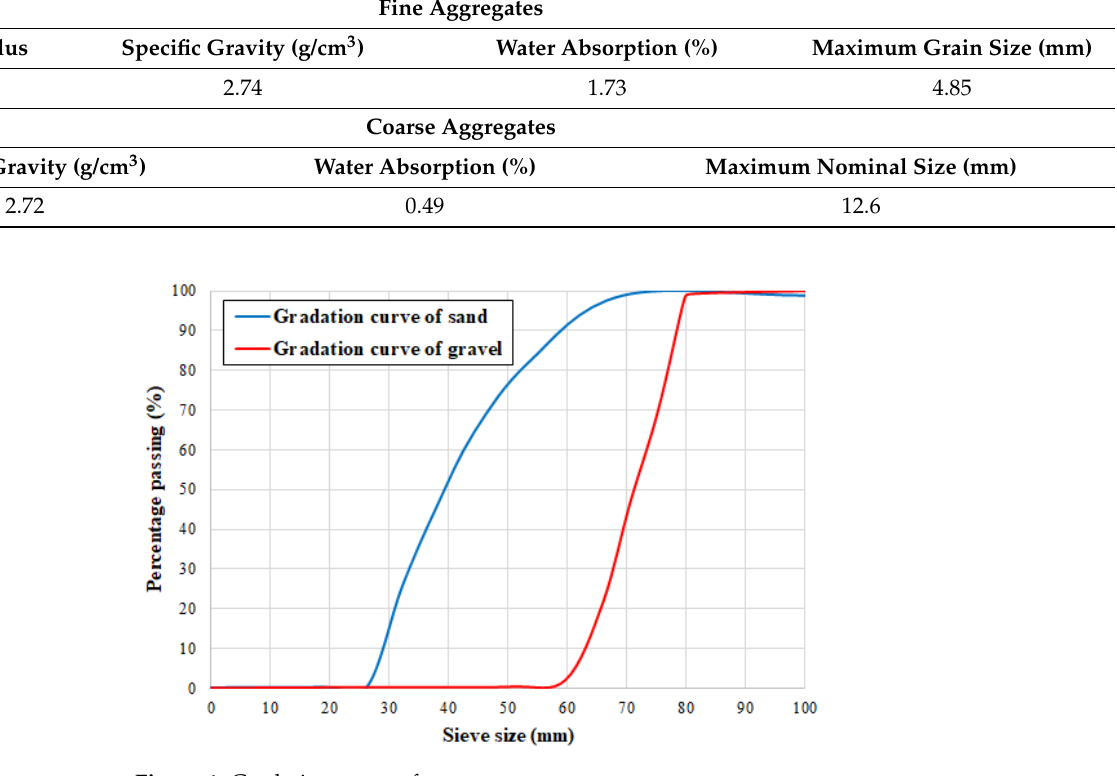
Table 3. Properties of the aggregates.